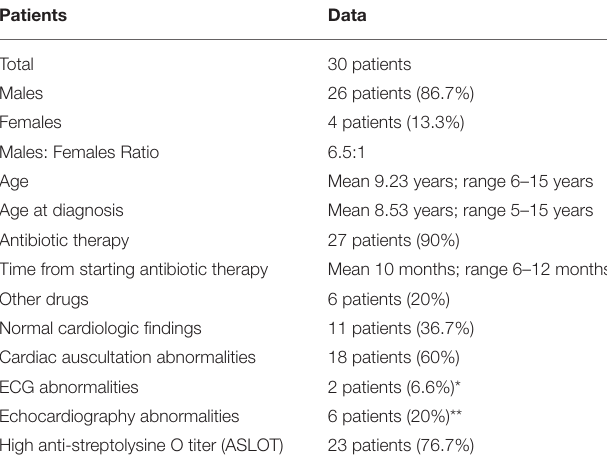
TABLE 1 | Patients characteristics and data collected. TABLE 2 | Distribution of cardiac involvement and ASLOT in the study PANS/PANDAS